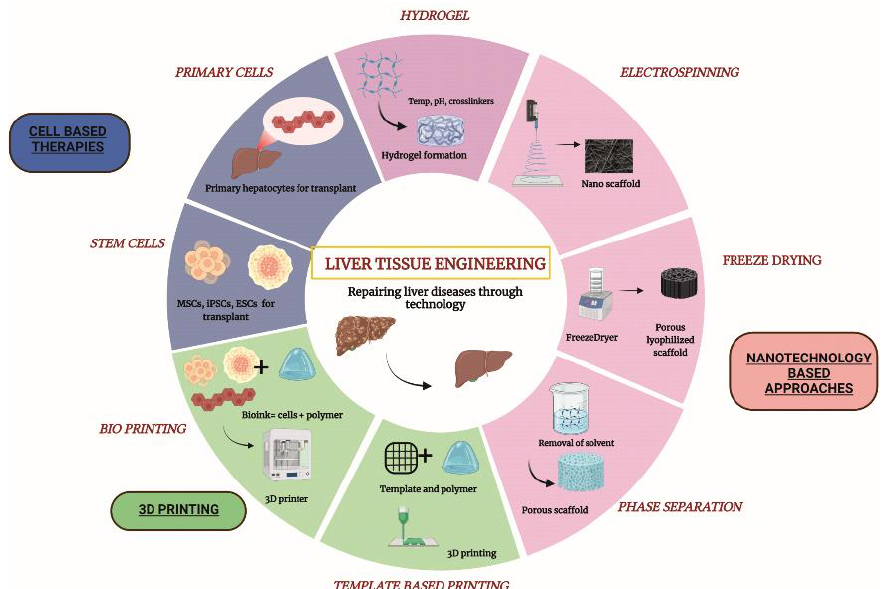
Figure 1. Different approaches used in liver tissue engineering. Three broad areas under liver tissue engineering categorized as cell-based approaches, 3D printing and nanotechnology-based approaches. MSCs—Mesenchymal Stem cells; iPSCs—induced pluripotent stem cells; ESCs—Embryonic Stem Cells. (Unpublished original picture by authors created using Biorender.com. )